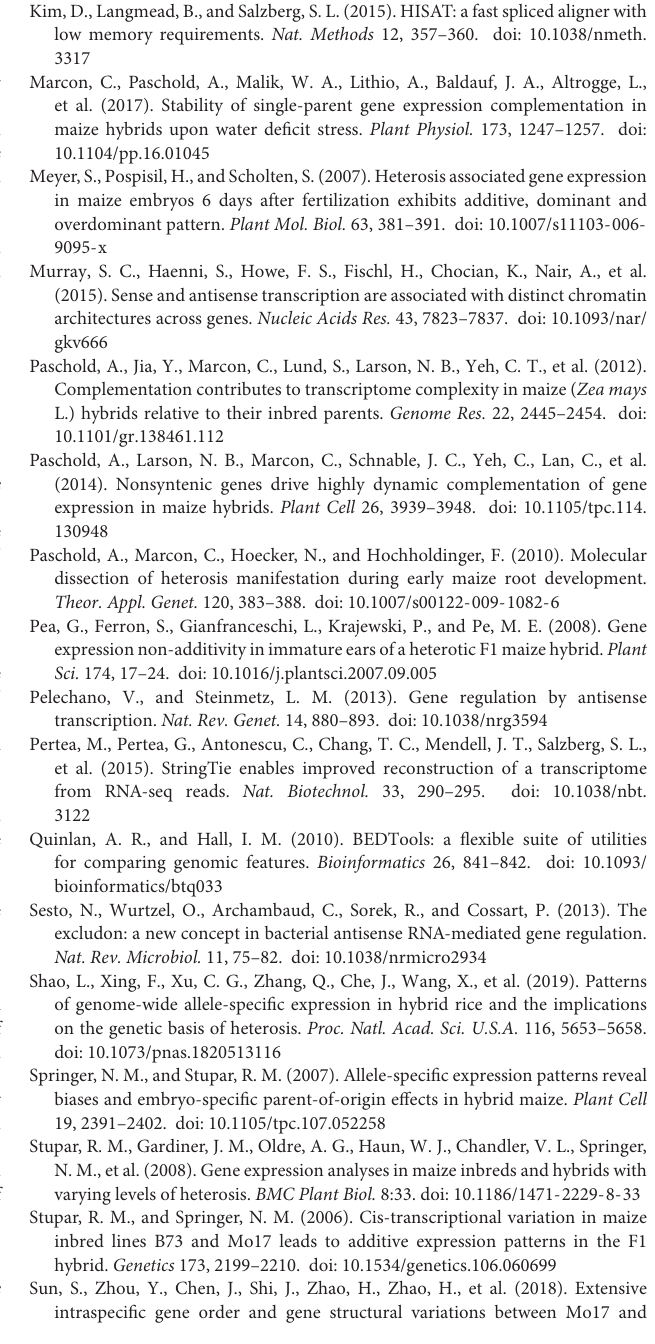
Supplementary Figure 3 | Expression heatmap of SPEA and its cognate sense RNA identified in immature ear tissue in three genotypes (B73, Mo17, and BM). Expression profile of SPEA_B (anti-sense) (A) and its cognate sense transcript (B) in three genotypes; Expression profile of SPEA_M (anti-sense) (C) and its cognate sense transcript (D) in three genotypes. Supplementary Figure 4 | Expression correlation ship between anti-sense and sense transcripts. (A) For SPEA_B detected in leaf tissue, the relative fold change of anti-sense (B73/Mo17) and sense transcript (B73/Mo17) was plotted. (B) For SPEA_M detected in leaf tissue, the relative fold change of anti-sense (B73/Mo17)